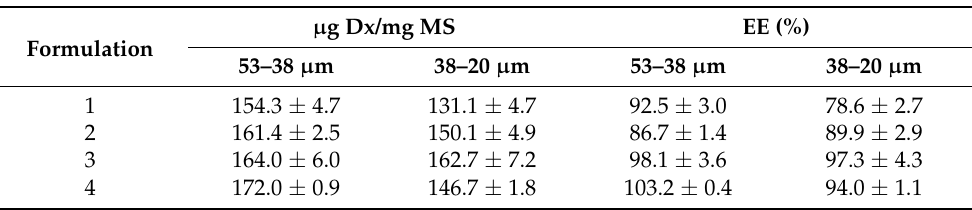
Table 3. Drug loading ( µ g Dx/mg MS) and percentage encapsulation efficiency (EE%) for the fractions of interest of each formulation ( n = 3).